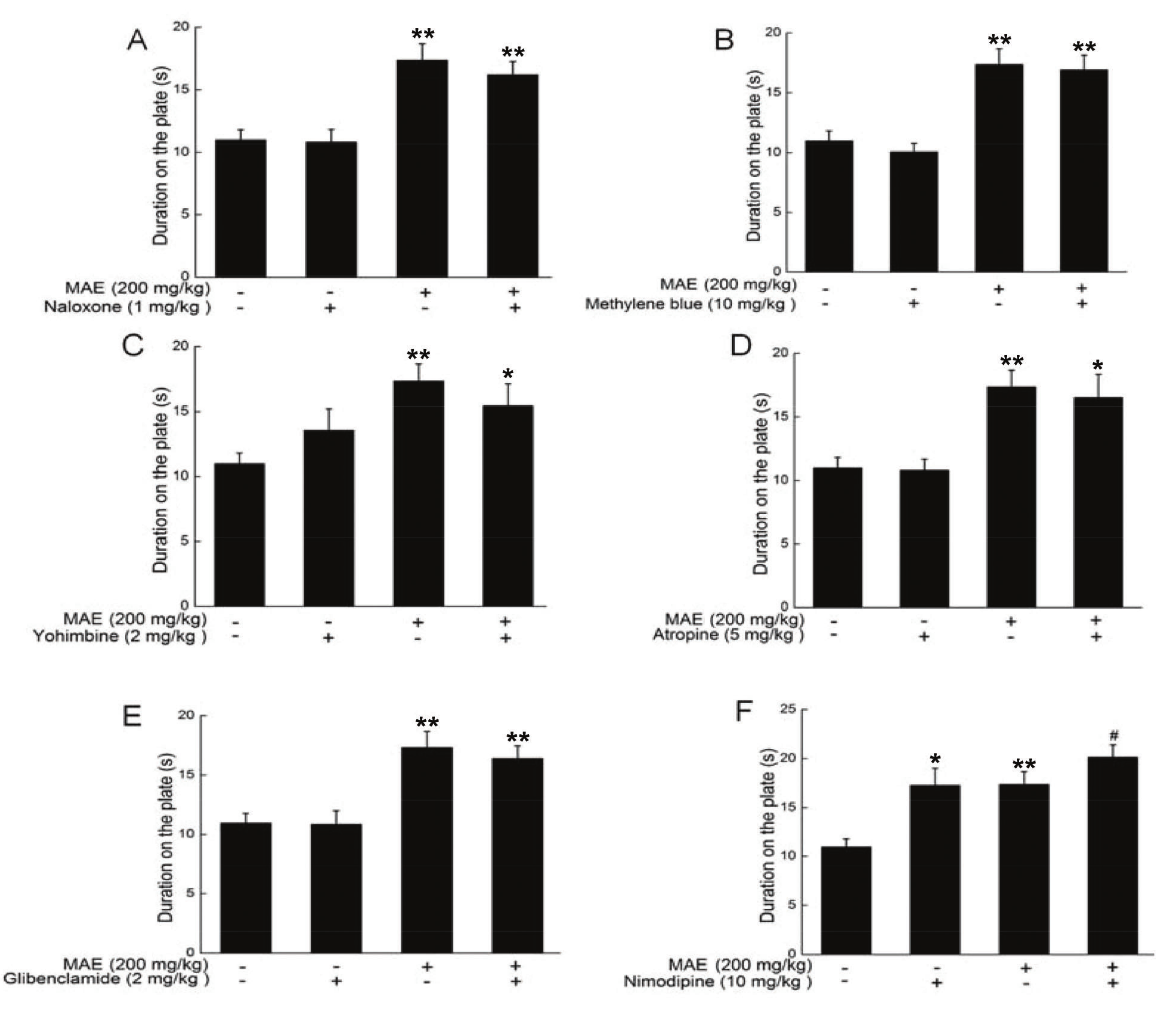
Figure 3. Mice were pre-treated with A , 1 mg/kg naloxone, B , 10 mg/kg methylene blue, C , 2 mg/kg yohimbine, D , 5 mg/kg atropine, E , 2 mg/kg glibenclamide, and F , 10 mg/kg nimodipine via intraperitoneal injection, followed by oral treatment with 200 mg/kg M. androsaceus extract (MAE) or deuterium-depleted water. After 30 min, a hot-plate test was performed and the paw withdrawal latency was recorded. Data are reported as means ± SE (n=10). *P o 0.05 and **P o 0.01 vs vehicle group. # P o 0.05 vs MAE only treated mice (one-way ANOVA followed by Dunn ’ s Figure 2B] and NE levels [P o 0.01, F(1,21) =13.90, and F(1,20)= 16.63 and 28.51; Figure 2D] in the hypothalami of the mice after a 30-s thermal stimulus.